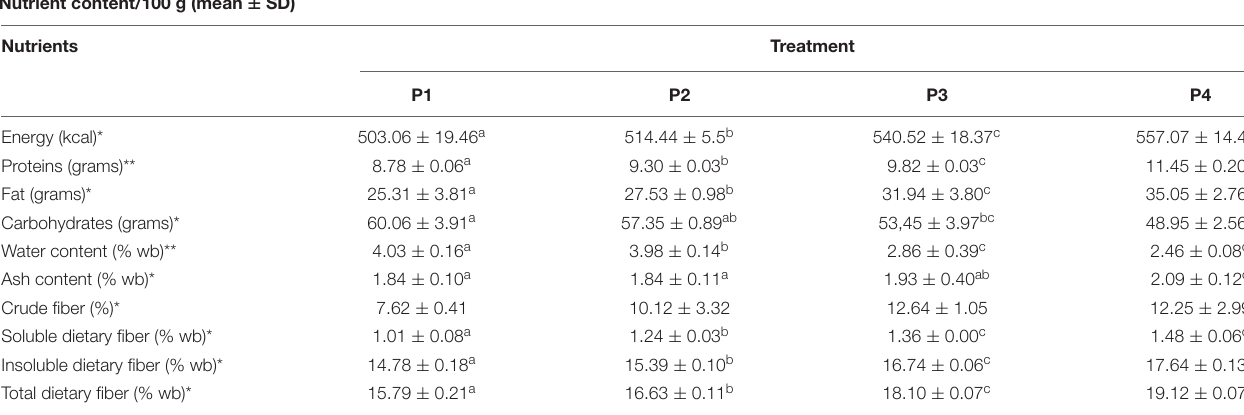
TABLE 2 | The results of proximate analysis of sagon formulated with lindur and soybean flour.